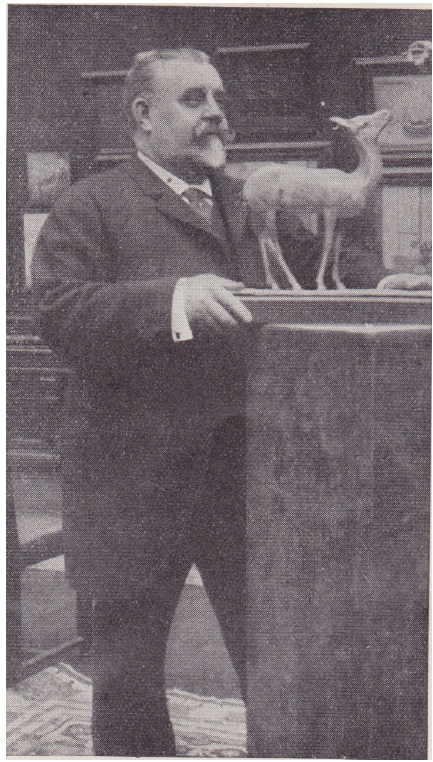
Figure 3. “Georges Petit, director of the famous gallery on rue de Sèze”, in “Les coulisses de la curiosité”, Lectures pour tous , 1911, p. 532. (Used by